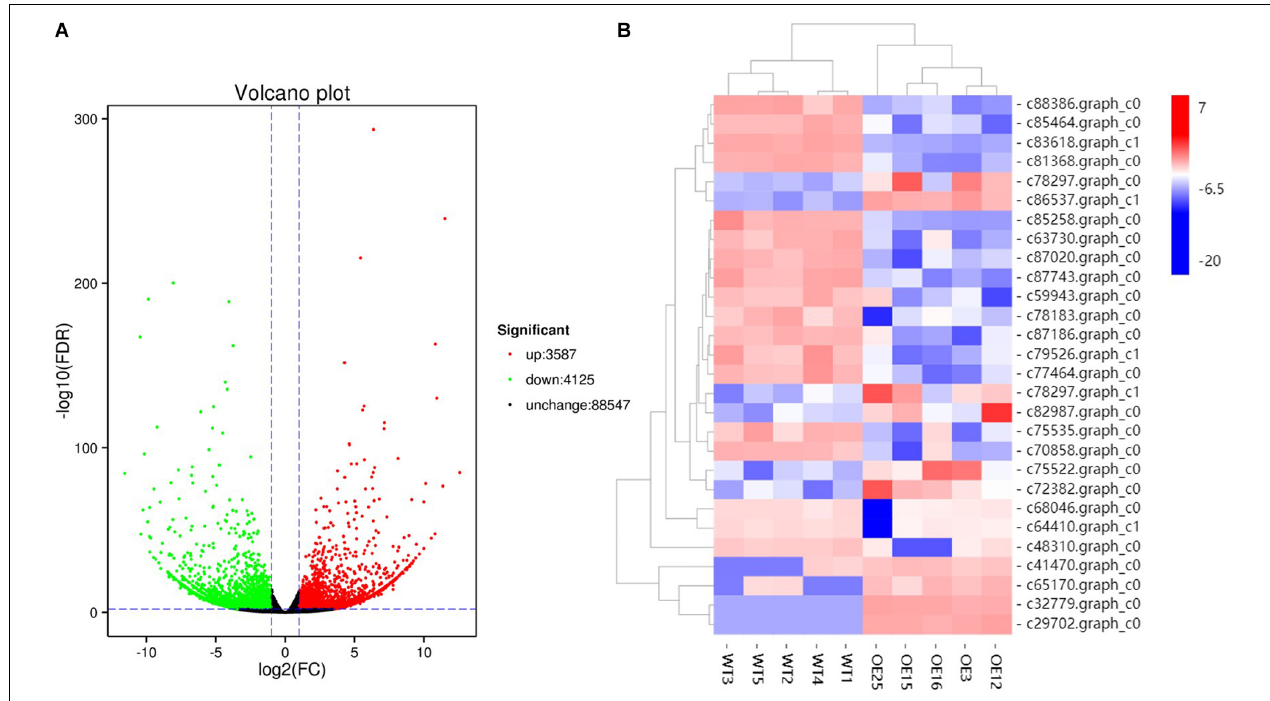
FIGURE 6 | The volcano plot of total differential expression genes (DEGs) (A) and heatmap of DEGs associated with flavonoids biosynthesis (B) between WT plants and OE-MsASMT1 transgenic